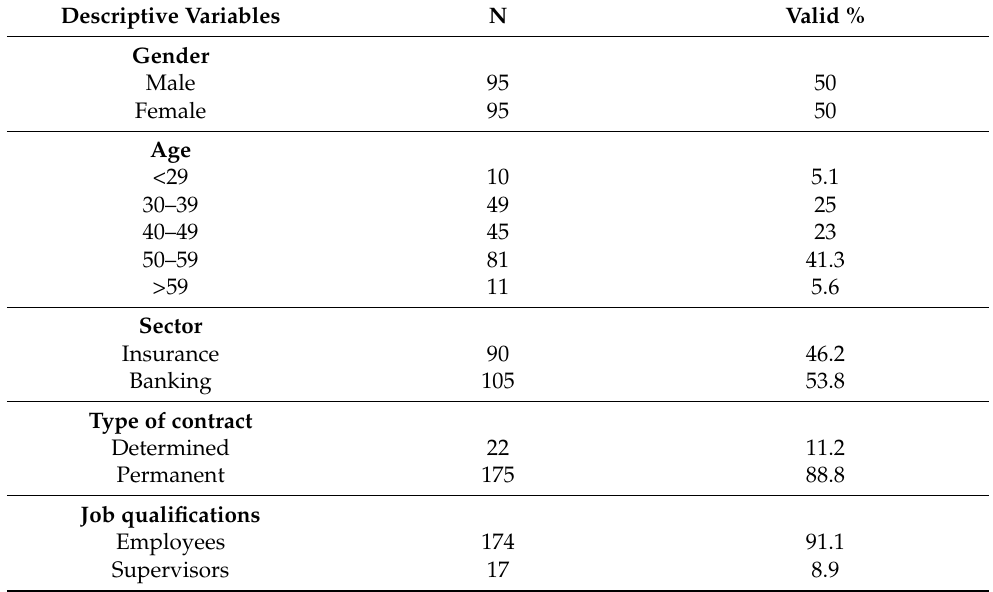
Table 1. Sociodemographic characteristics of the